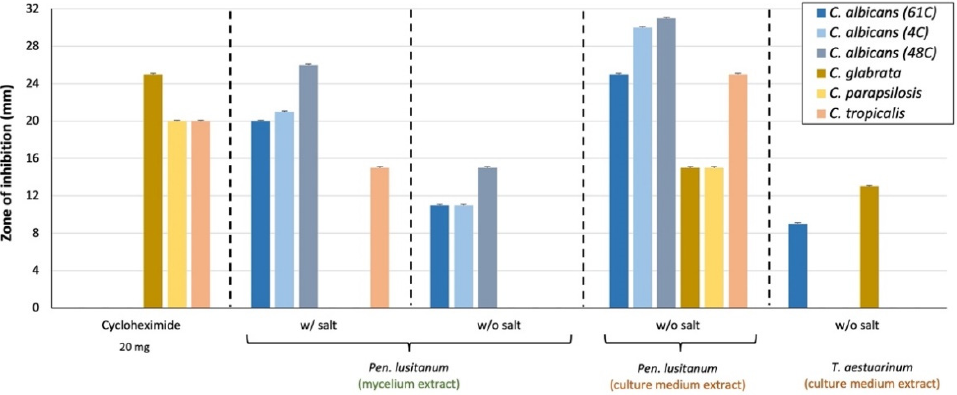
Figure 3. Anti-fungal activity of the mycelium and culture media extracts of Pen. lusitanum (MUM 18.49) and T. aestuarinum (MUM 19.05) using the disk diffusion assay. Data are shown as average ( n = 3) ± standard error. Extracts not inducing inhibition halos were not included.